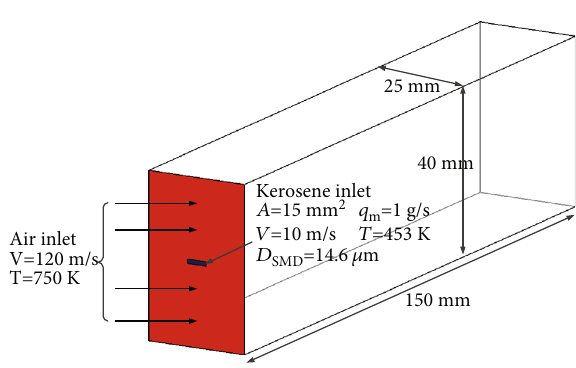
Figure 3: Schematic of the computational domain and boundary conditions for validation of the Euler-Lagrange method.